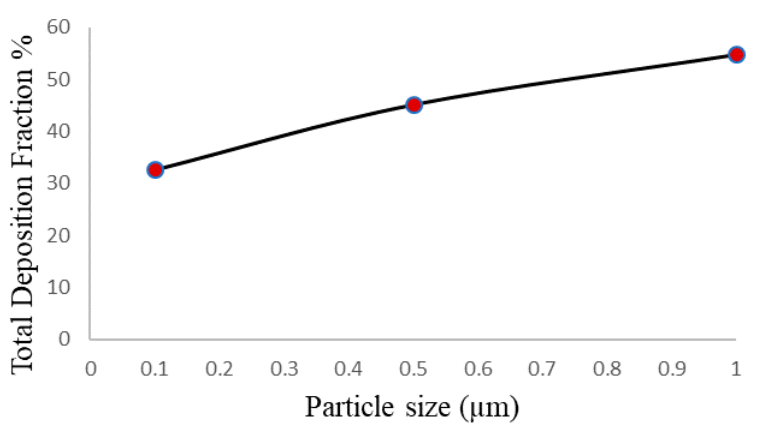
Figure 16. Total deposition fraction of CSP for various particle sizes.